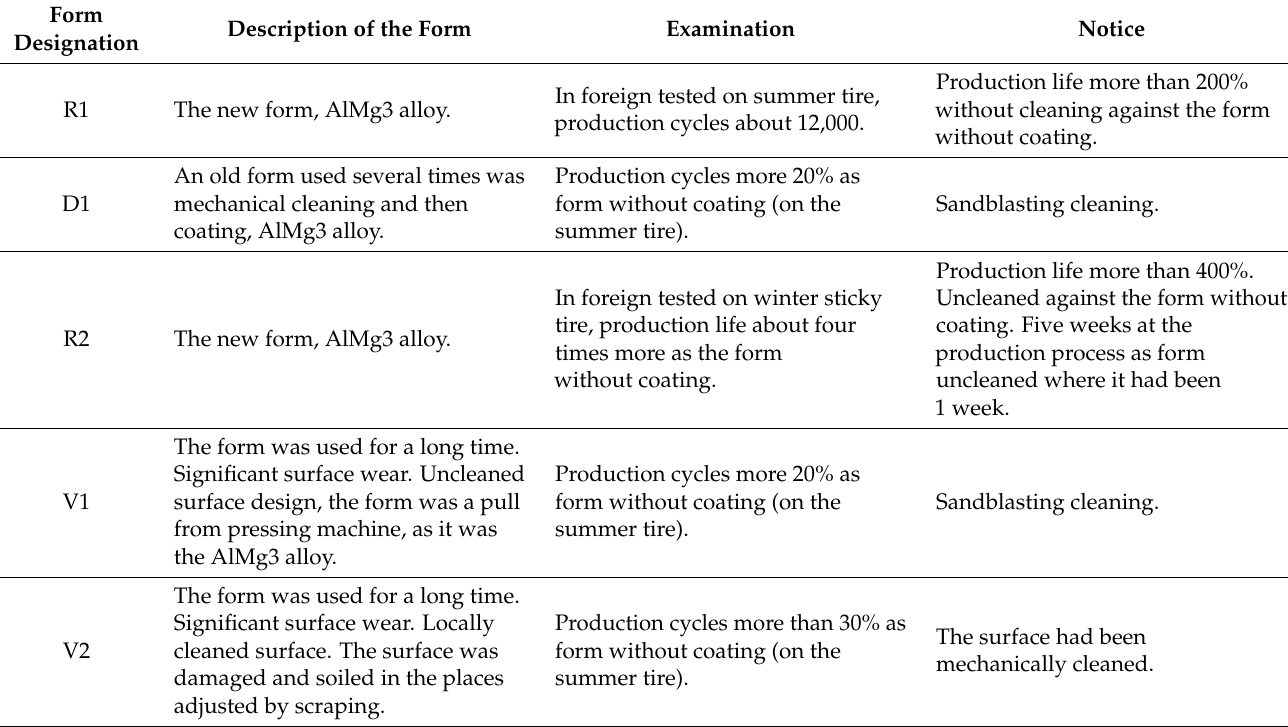
Table 1. Overview of testing new and used